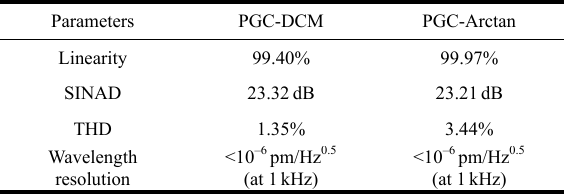
Fig. 4 Flow chart of the PGC demodulation technology. Table 1 Parameters comparison of two demodulation